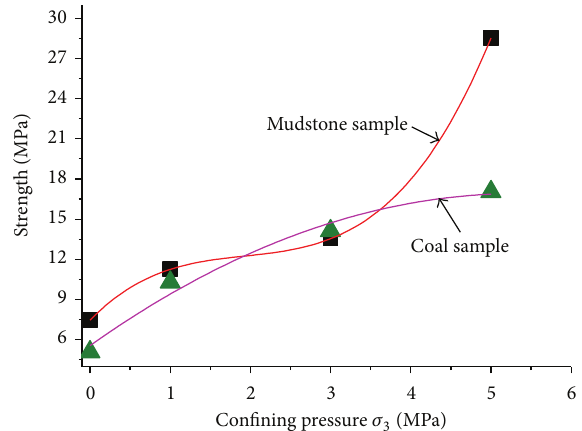
Figure 11: Relation of elastic modulus of mudstone with confining pressure.